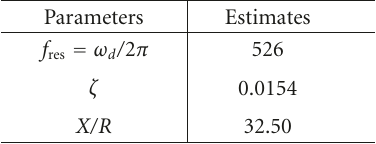
Table 7: Estimation results for actual